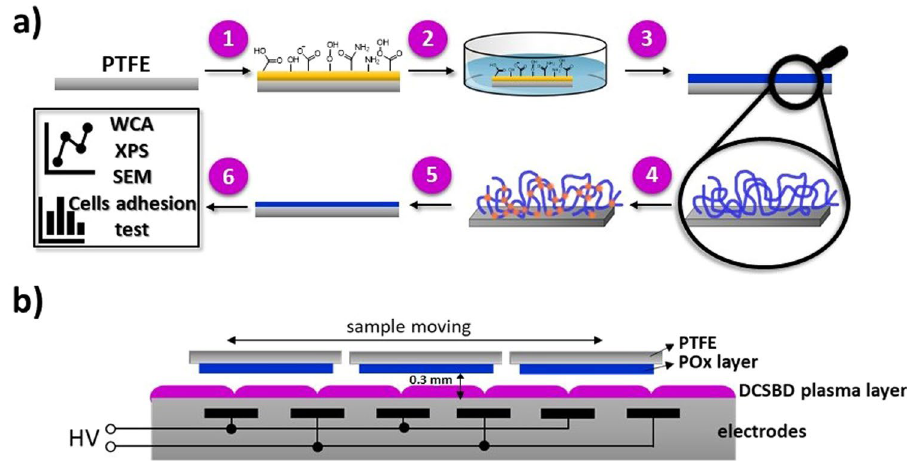
Figure 1. Schematic representation of experimental procedure and DCSBD plasma source. ( a ) Experimental procedure for preparation of PMEOx-based coating: (1) plasma activation of PTFE surface, (2) dip-coating of PMEOx layer, (3) drying, (4) plasma post-treatment of PMEOx layer (air and argon used as working gases), (5) washing in distilled water, (6) characterization; ( b ) Schematic cross-section of DCSBD plasma source with an illustration of sample moving perpendicularly to the axes of the electrodes.